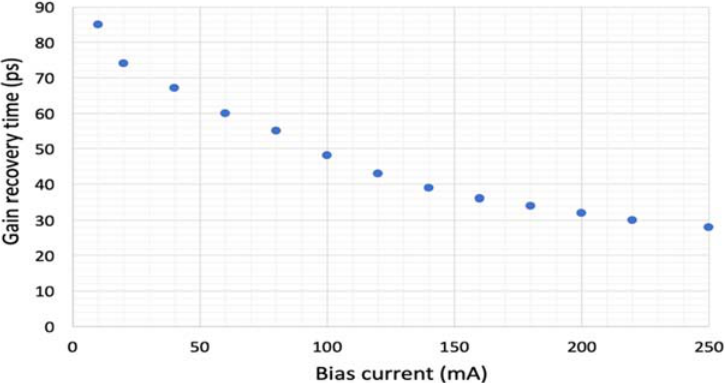
Figure 2. SOA’s gain recovery time against the bias current.